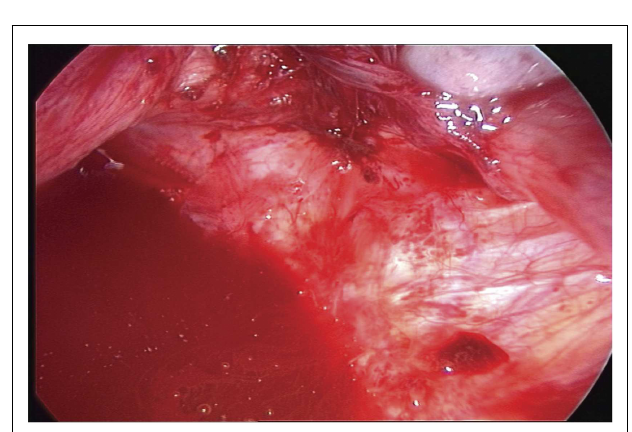
FIGURE 9 |Typical aspect of small red peritoneal excrescences in a context of extensive endometriosis .